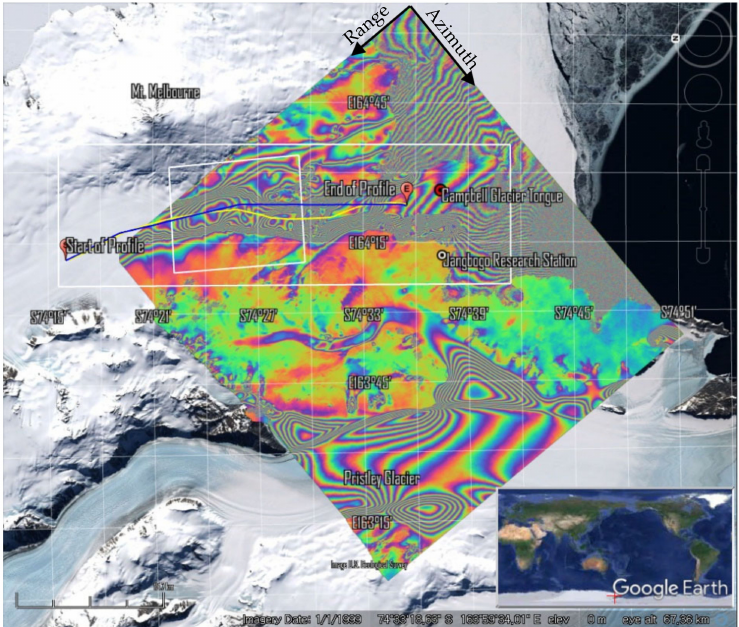
Figure 2. An example of one-day DInSAR images (the pair of [20100616_20100617]). The yellow line is the steepest ice-velocity gradient line at the center of the valley while the blue line is one of the IPR routes close to the white line. White boxes are image areas for Figure 4 (smaller one) and Figure 6 (bigger one), respectively. Note that part of the yellow line is hidden under the blue line, but they share the same starting and ending